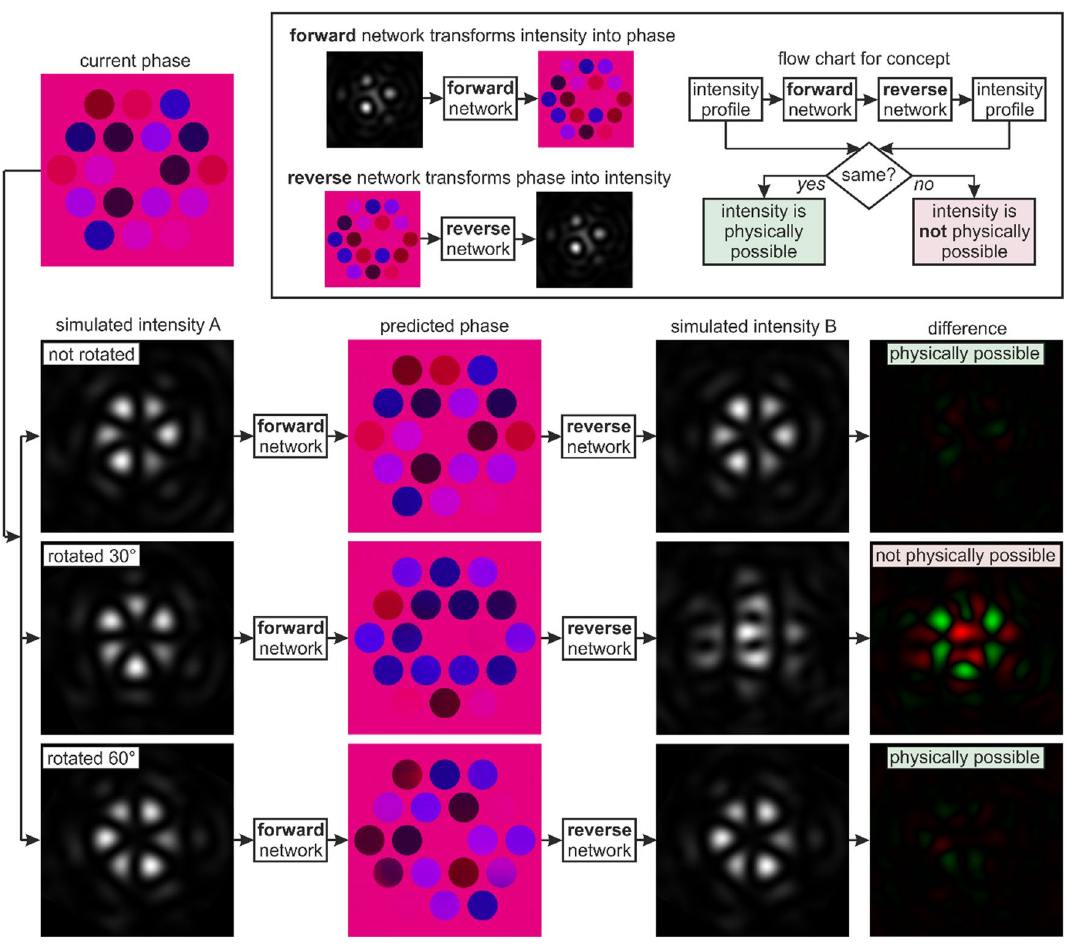
Figure 5. Concept of using a forward and reverse neural network, in combination, for single step identification of whether an intensity profile is physically possible. In this case, the approach identifies whether a particular intensity profile is possible in this simulation. This method is possible as all simulated phases lead to simulated intensities, but not all simulated intensities lead to simulated phases. Due to the sixfold rotational symmetry of the fibre array, a 30-degree rotation of the ring-shaped intensity profile is not a possible intensity profile, and hence there is no cyclicity between the domains (i.e. there is a difference between the input and output intensity profile). The difference column highlights where intensity is removed from the input intensity (green) or added to the input intensity (red), when comparing with the output intensity. The image pixel value for the red and green range from 0 to 255 according to the difference in pixel values for the input and output intensity